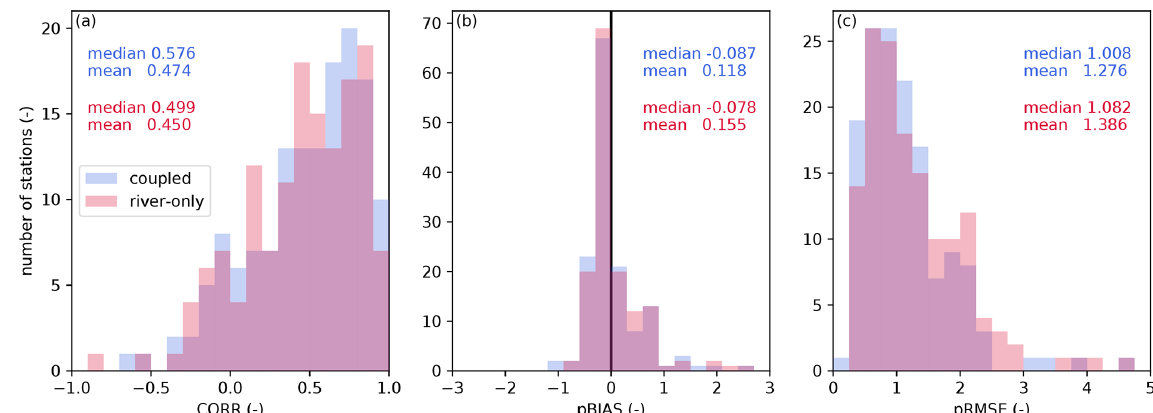
Figure 4. Comparison between reproducibility indices of river discharge. Bars are the histograms of each index, and the numbers indicate the associated median and mean values. Blue (red) bars and written values show the results of the coupled (river-only) simulation. Panel (a) shows CORR, panel (b) shows pBIAS, and panel (c) shows pRMSE.